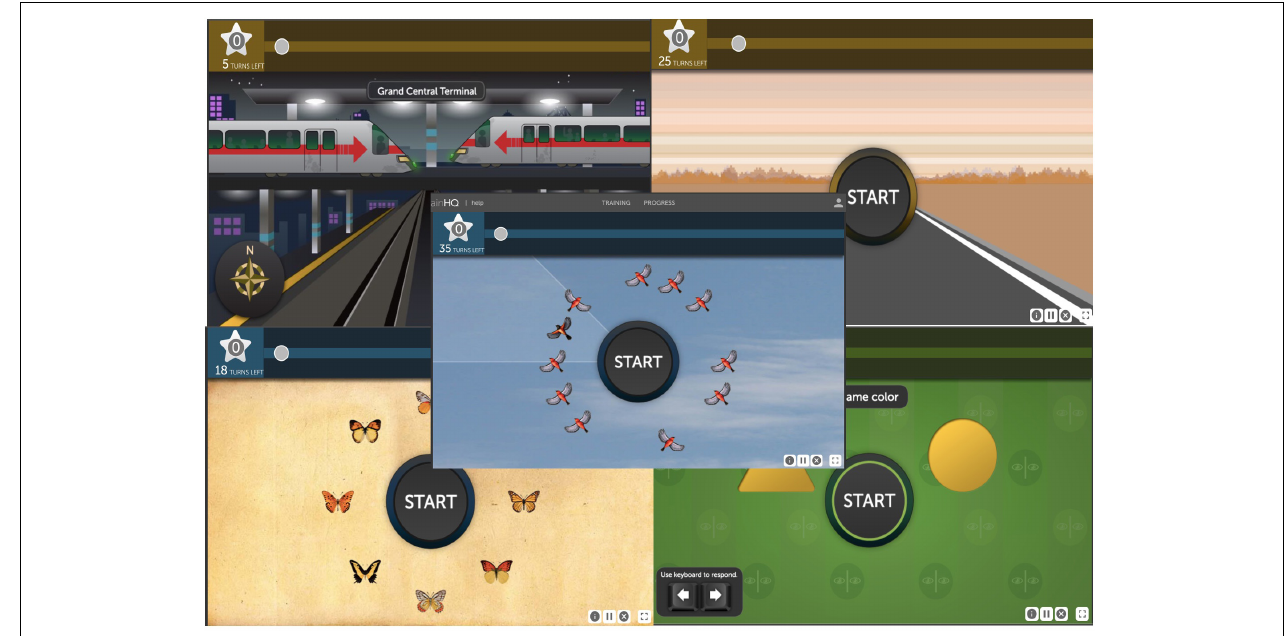
FIGURE 1 | Screenshot from the Cognitive Training